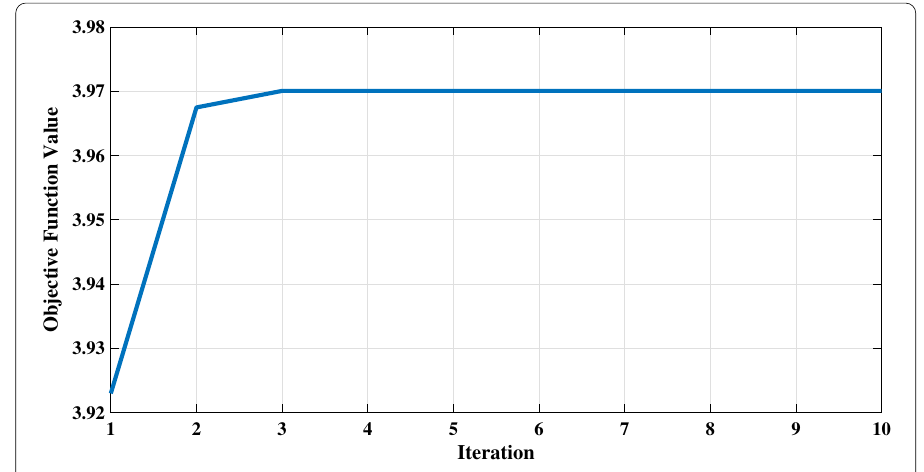
Fig. 5 Objective function value versus iteration number